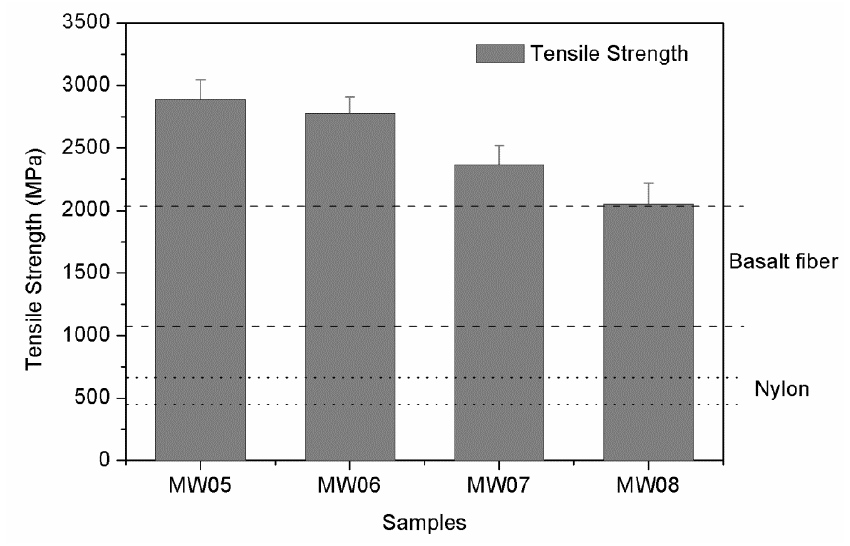
Figure 8. Mean tensile strength of the fiber (MW05, MW06, MW07,